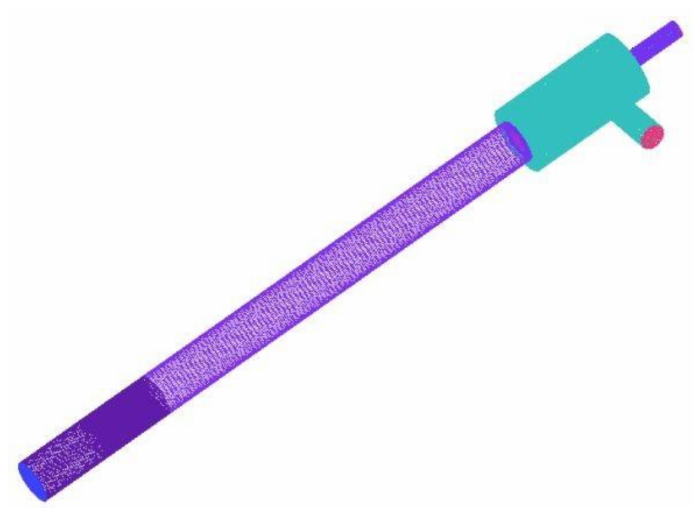
Figure 3. Mesh model of the